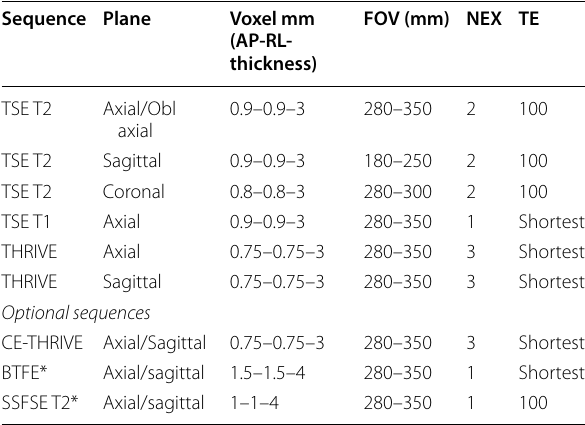
* Performed with rectal distension